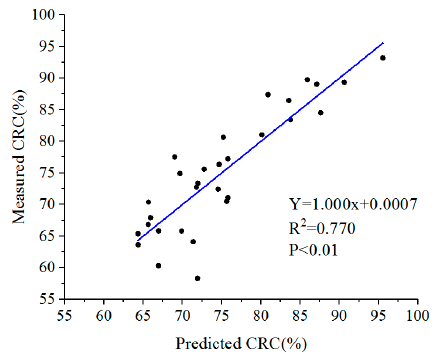
Figure 7. Scatterplot between field measured CRC and optimal model estimated CRC.